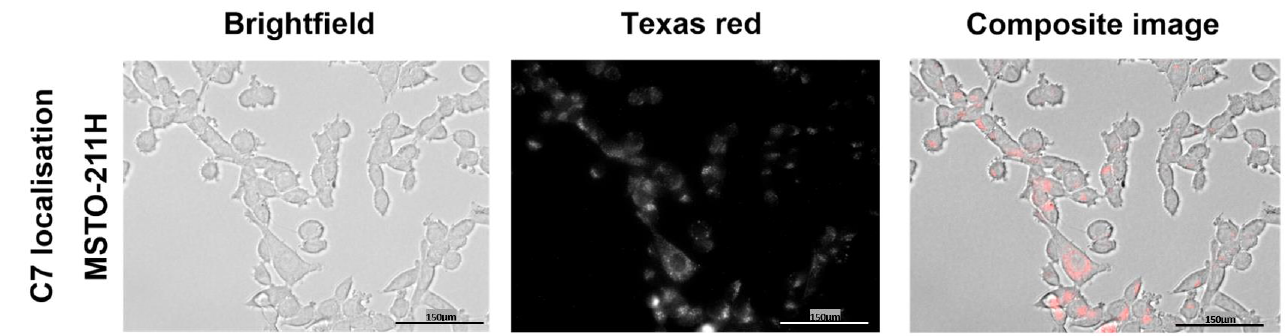
Figure 2. Example of C7SHU cellular localization. MSTO-211H cells were treated with 20 µ g/mL PS C7SHU at a concentration of 10 µ g/mL for 24 h. Images present are presented as a bright field, a Texas red channel and a composite image. Scale bar: 150 µ m.